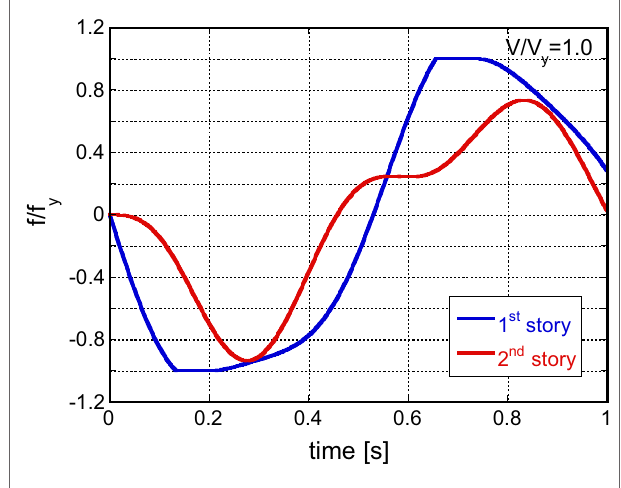
FigUre 3 | example of the time histories of the restoring forces in the first and second stories for a model of equal mass, equal story stiffness, and equal yield interstory drift subjected to the single impulse at t = 0 with V / V y = 1.0 .